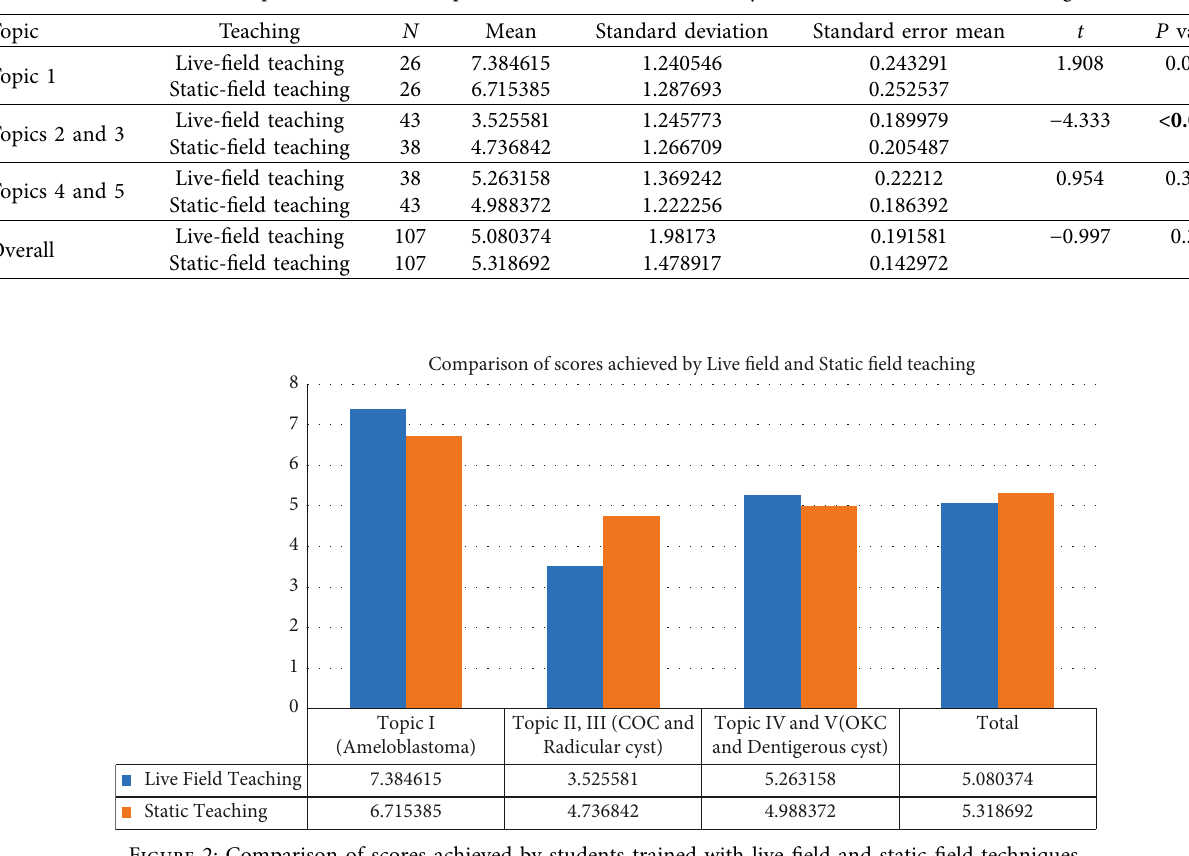
Figure 1: The sequence of randomization and classes uptaken for the score assessment. Table 1: The paired t -test for comparison of the scores achieved by live-field and static-field teaching.